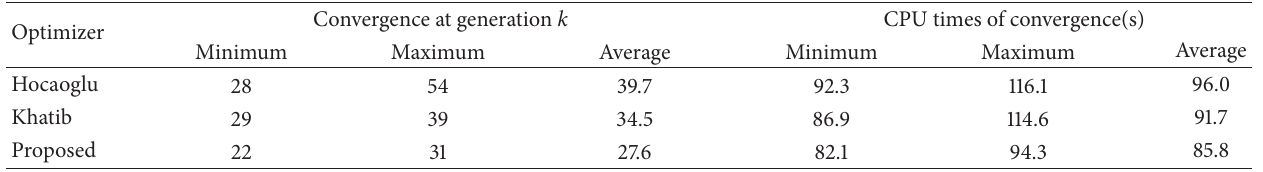
Table 7: The algorithm convergence analysis.